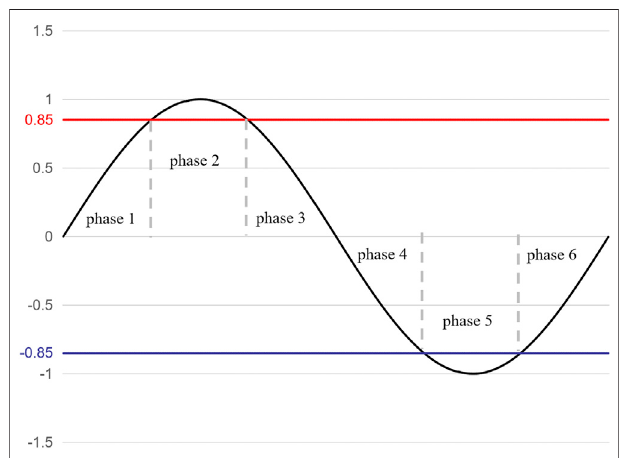
FIGURE 6 | Phase division of oscillation period of EAP index. The red/ blue line represents the +0.85/-0.85 level.